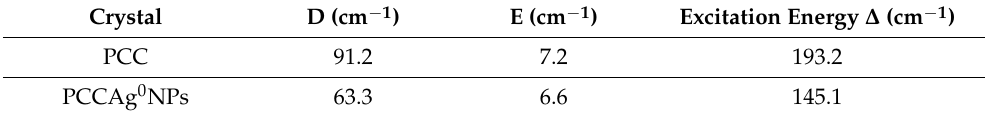
Table 8. Results of Ab initio calculations.